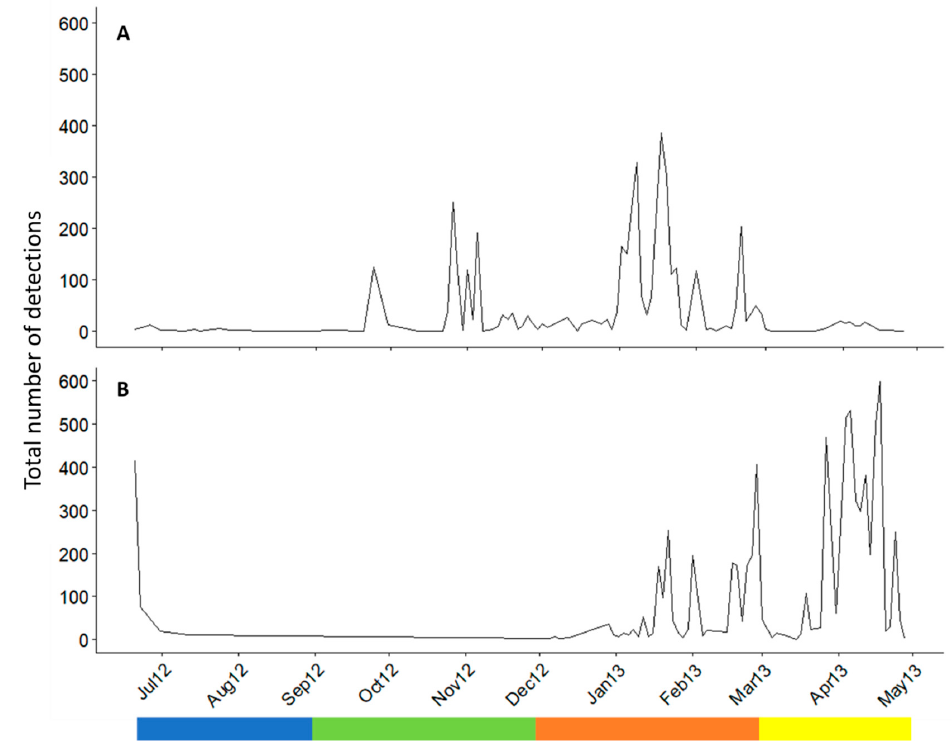
Figure 4. Total number of D ( A ) and SEP ( B ) call detections for 10 consecutive months of recording in Melimoyu: 19 June 2012–28 April 2013. Color bar represents seasons (blue: winter; green: spring; orange: summer; yellow: